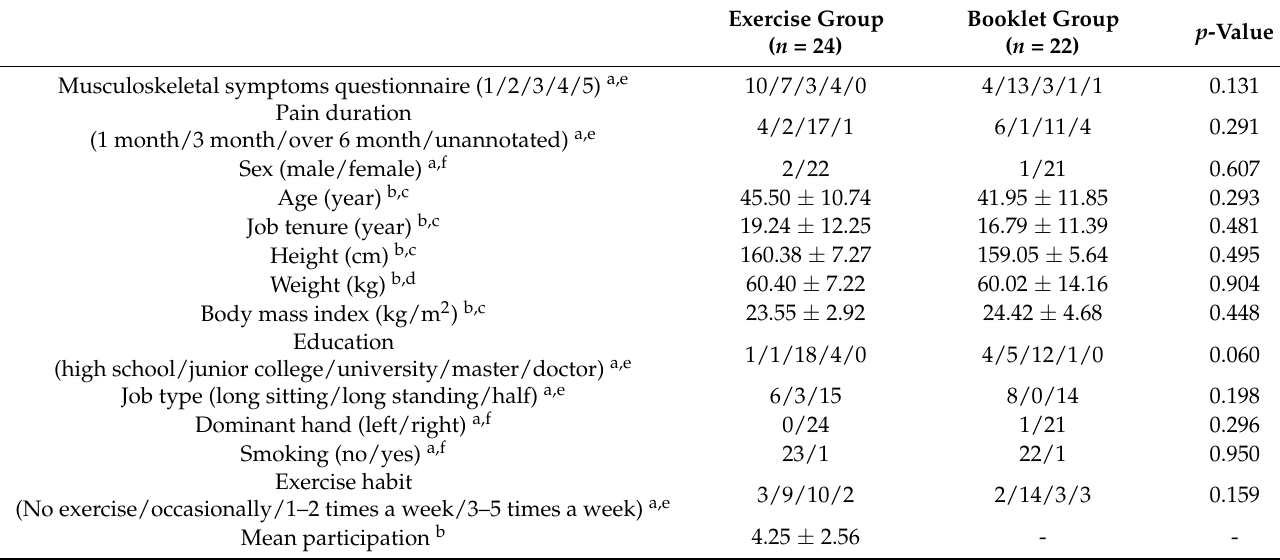
Table 1. Demographic data at the baseline.